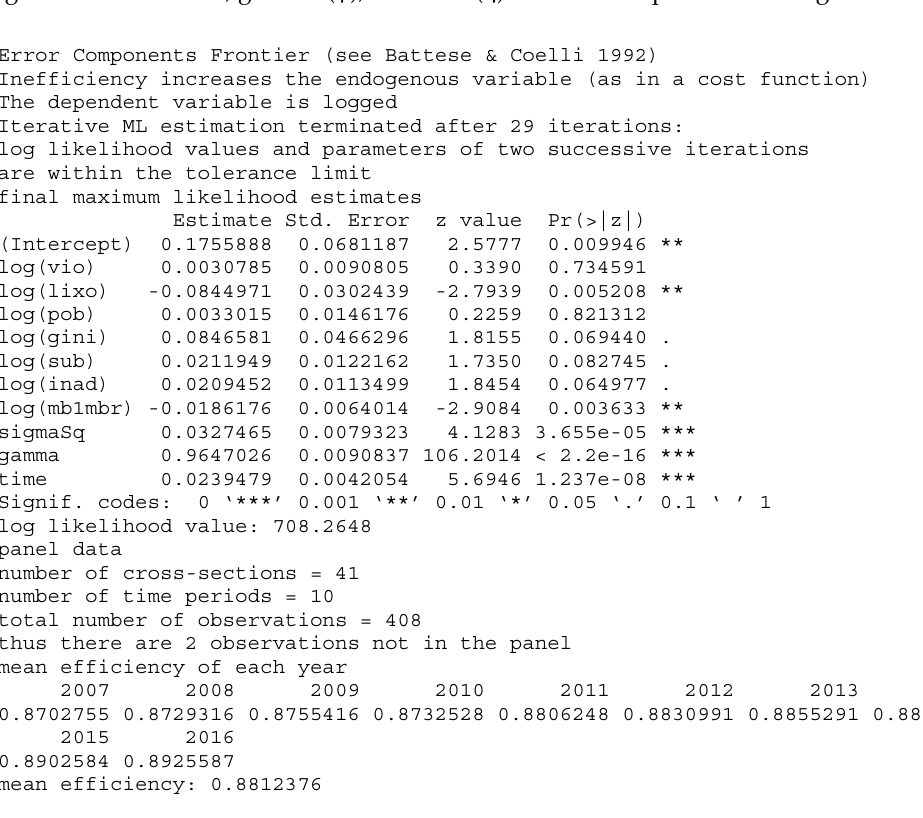
Figure 10. Fitted model.